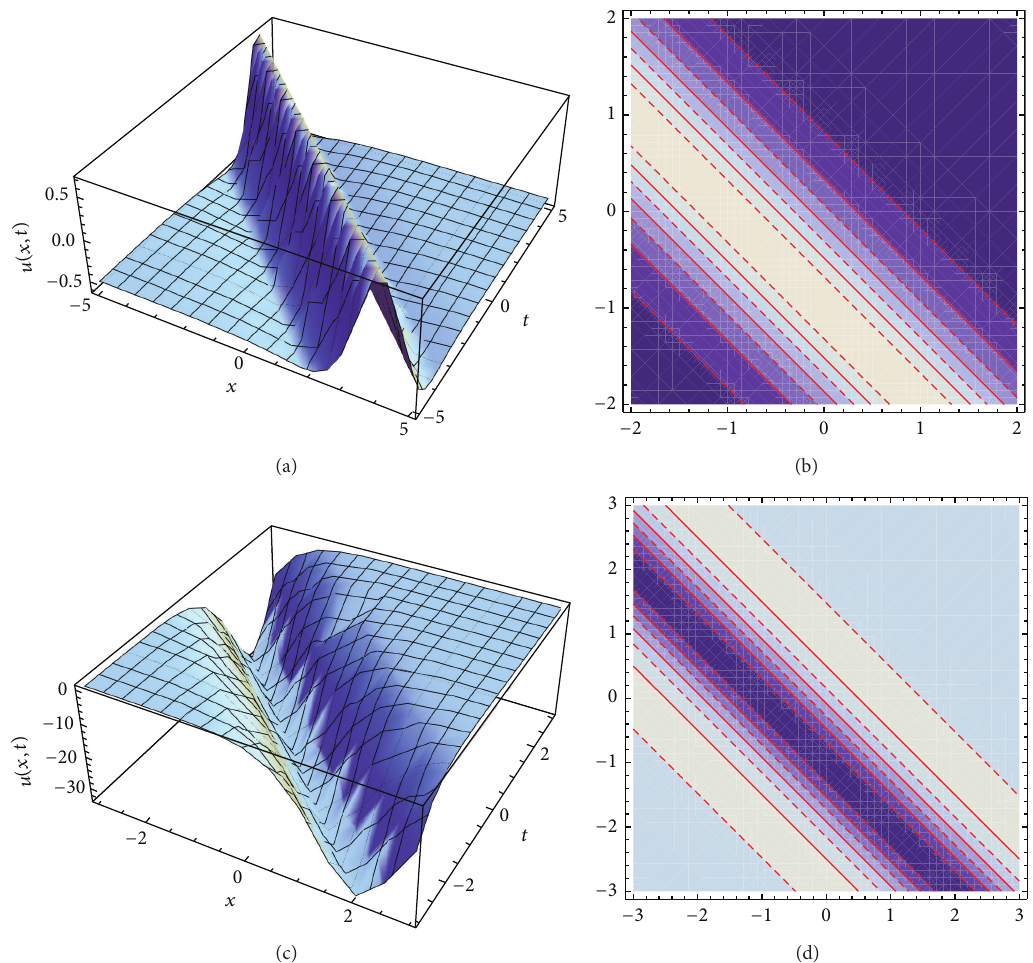
Figure 1: Travelling waves solutions (9) and (10) with various different shapes are plotted: bright solitary waves in (a) and contour plot in (b). Travelling waves solutions (13) and (14) with various different shapes are plotted: dark solitary waves in (c) and contour plot in